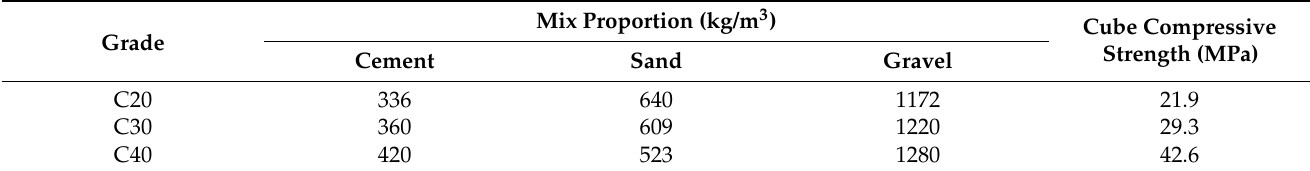
Table 3. Material properties of